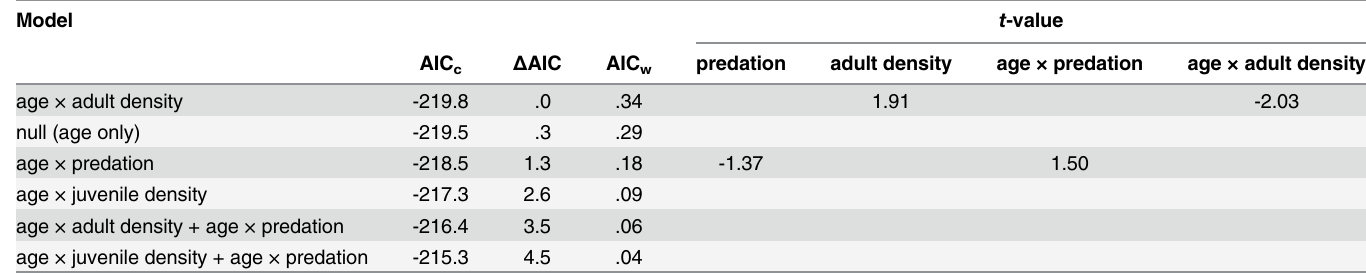
Table 2. Predictors of growth rate among populations of the Pacific leaping blenny. Effect sizes are represented by t -values and were considered to be statistically distinguishable effects if larger then 1.96. N females,populations =